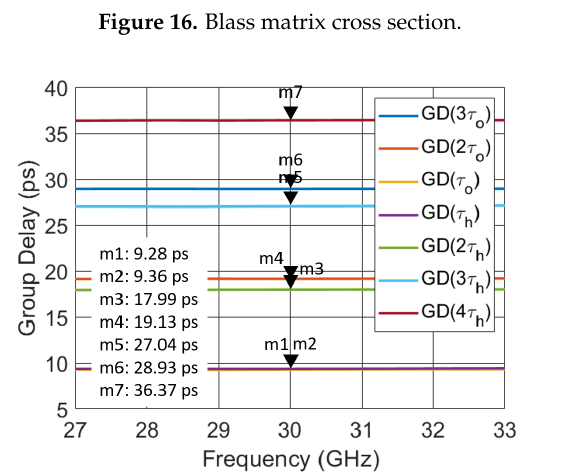
Figure 17. Group delay response of the delay lines of the Blass